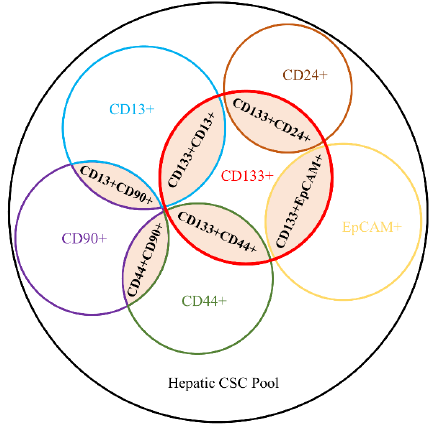
Figure 1. A cartoon showing the heterogeneous nature of CSCs in HCC. Illustrated are six subsets with individual surface marker expressions harboring distinct stemness features inside the hepatic CSC pool. CSCs with a combined expression of surface markers (shaded) possessed more vital tumor-initiating capacities than unique marker-expressed CSCs.